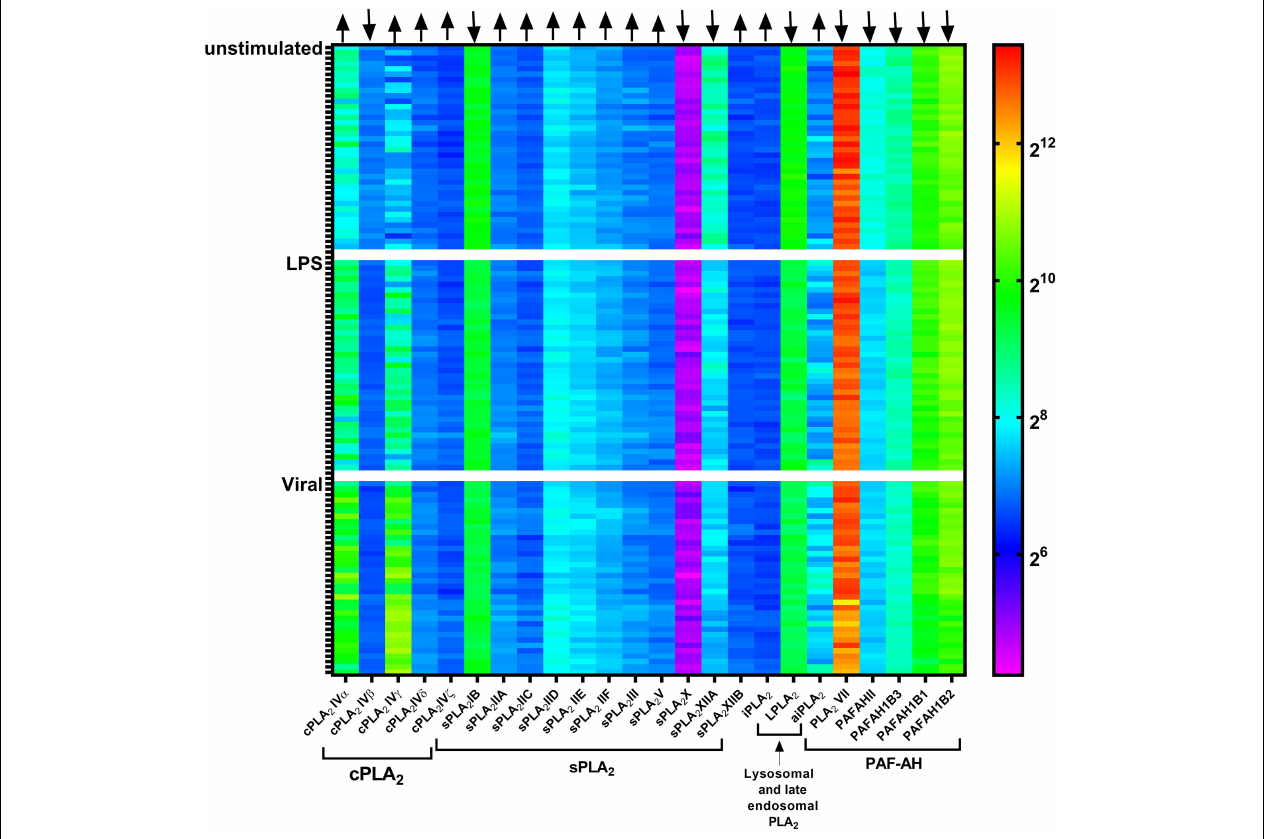
FIGURE 1 | Gene microarray heatmap of phospholipase A 2 (PLA 2 ) gene expression in monocyte-derived dendritic cells from a published microarray study. Each column shows a PLA 2 gene. Each row shows dendritic cells derived from an individual donor, either unstimulated or stimulated with LPS or the influenza virus (Viral). Microarray data is from the reference (Lee et al.,